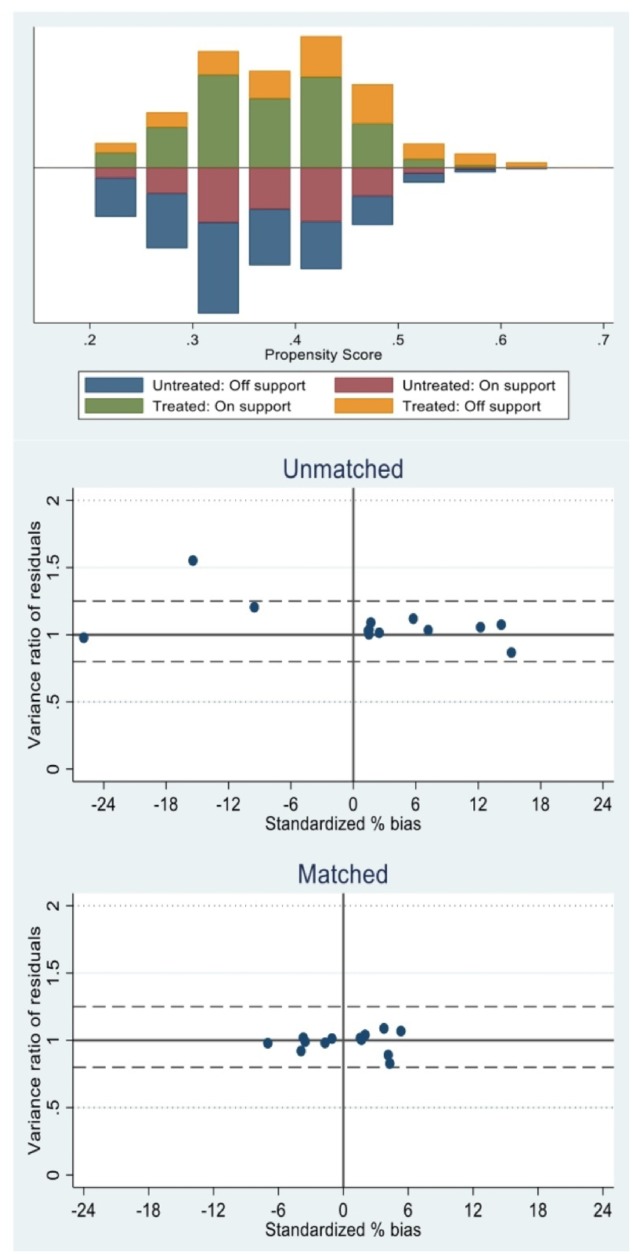
Distribution of propensity scores using nearest neighbour matching for financial risk protection across treatment and comparison groups and representation of standardized bias between matched and unmatched samples, Ghana 2012–13.